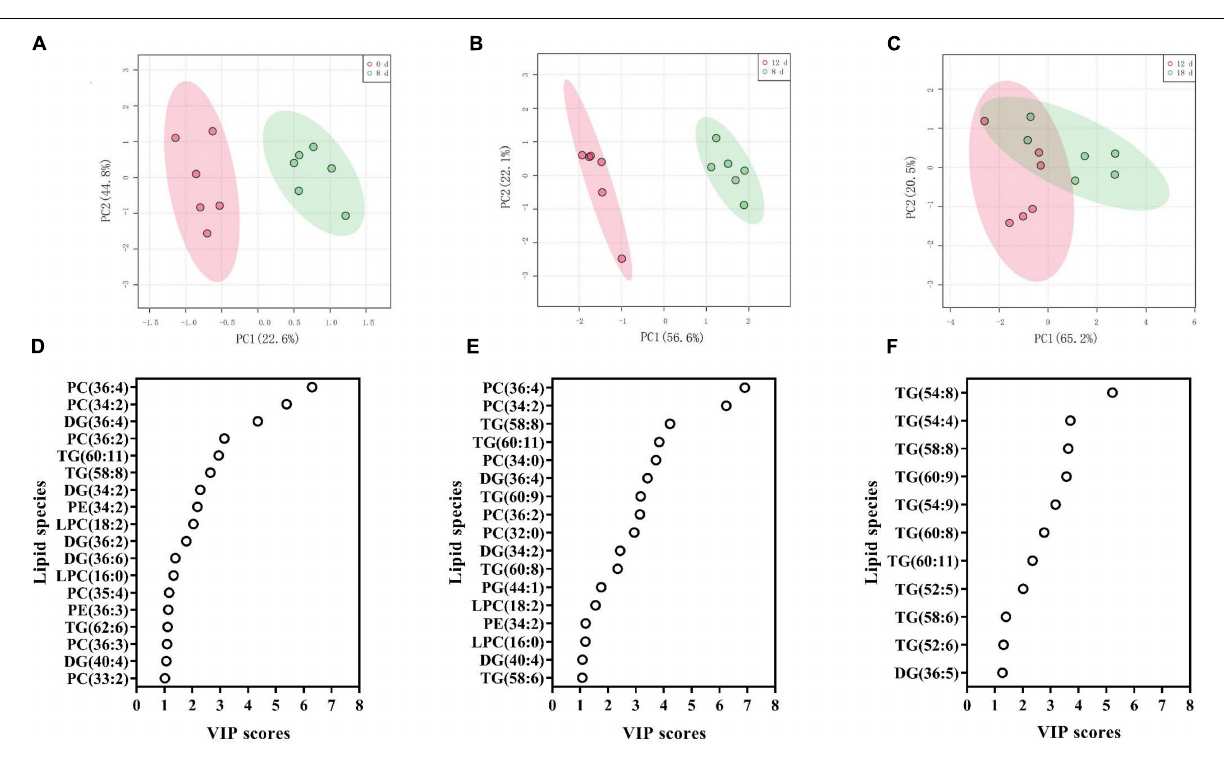
FIGURE 8 | (A–C) PLS-DA score plots demonstrating the differences between adjacent aging time points: (A) 0 d vs. 8 d, (B) 8 d vs. 12 d, and (C) 12 d vs. 18 d. (D–F) PLS-DA VIP scores identifying critical lipid species (VIP > 1 and p < 0.05) that differentiated between treatments: (D) 0 d vs. 8 d, (E) 8 d vs. 12 d, and (F) 12 d vs. 18 d. Lipid molecular species are identified as total acyl carbons: total double